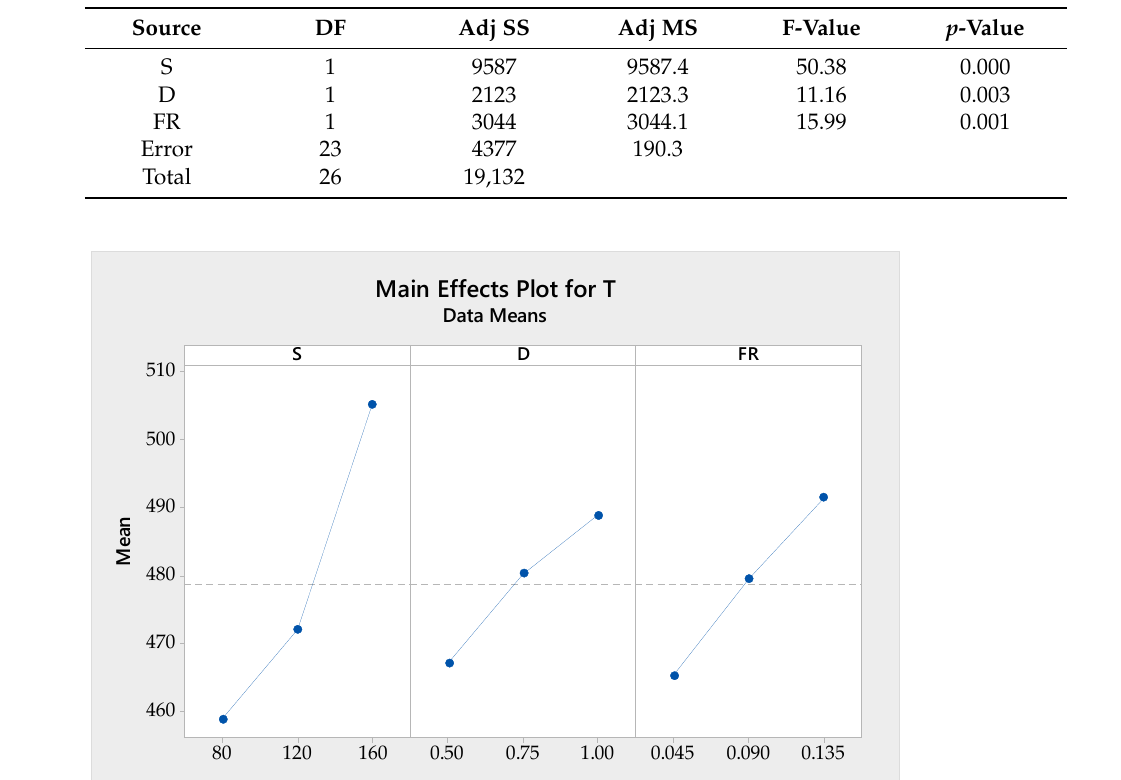
Table 10. ANOVA results for T using wiper cutting edge.